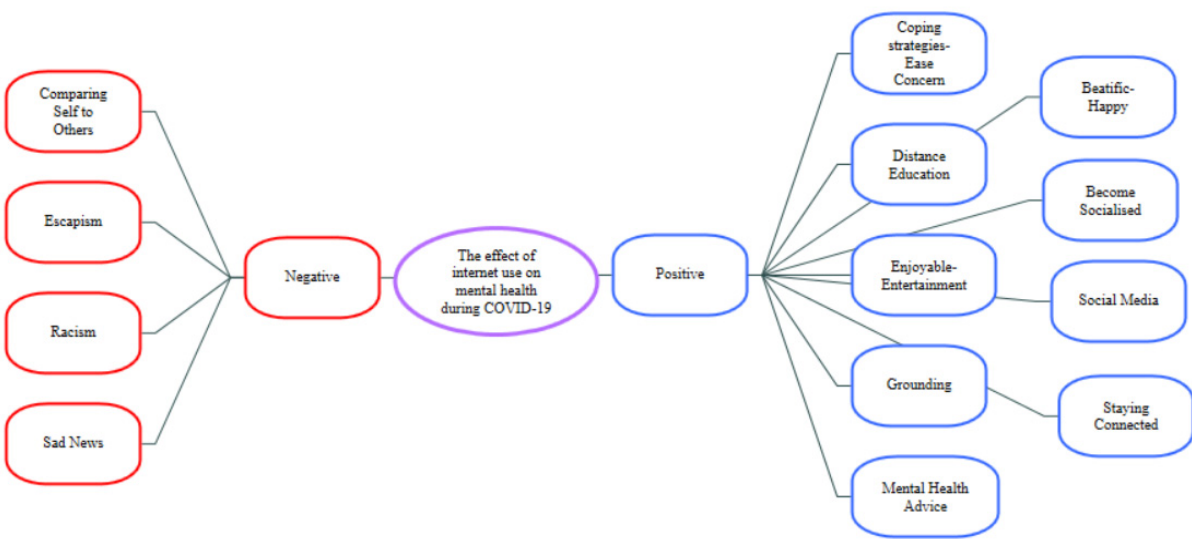
Figure 4. Themes/Sub–themes regarding the effect of internet use on mental health during COVID-19.